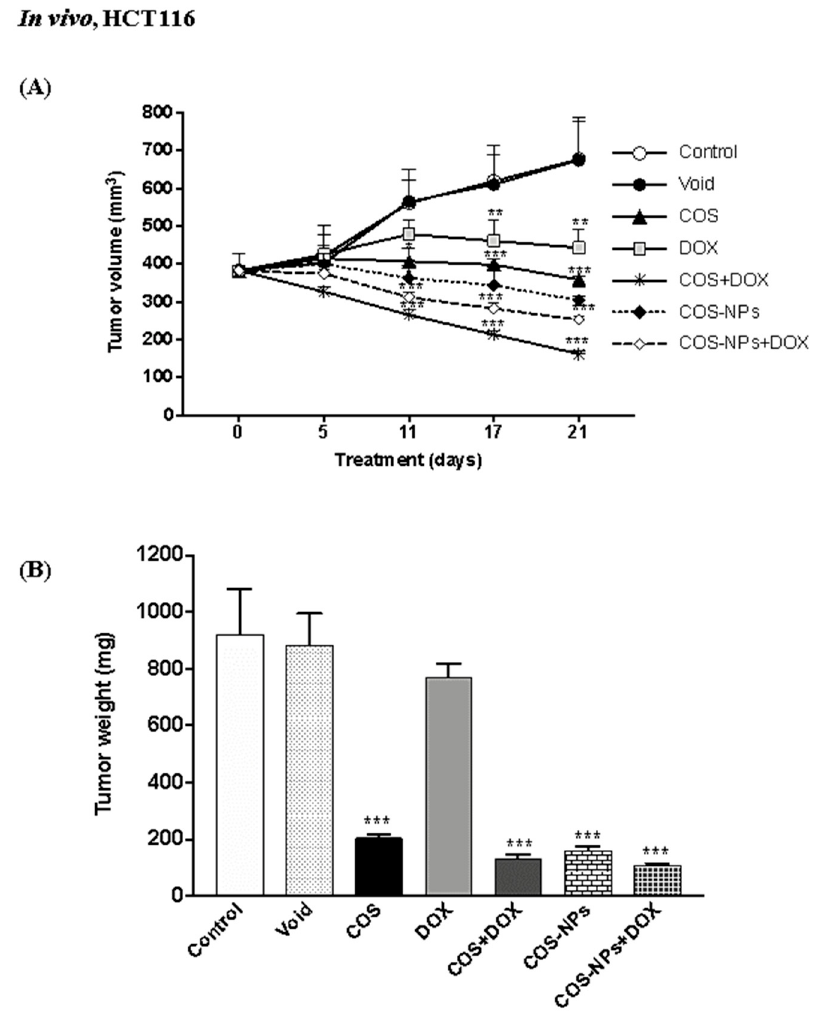
Figure 7. Tumor growth after 21 days in nude mice implanted with HCT116 cell lines treated with costunolide (COS), doxorubicin (DOX), costunolide + doxorubicin (COS+DOX), costunolide- nanoparticles (COS-NPs), and costunolide-nanoparticles + doxorubicin (COS-NPs+DOX). ( A ) Tumor volumes. ( B ) Tumor weight. Values are presented as mean ± SD. * p < 0.05, **p < 0.01, and *** p < 0.001.